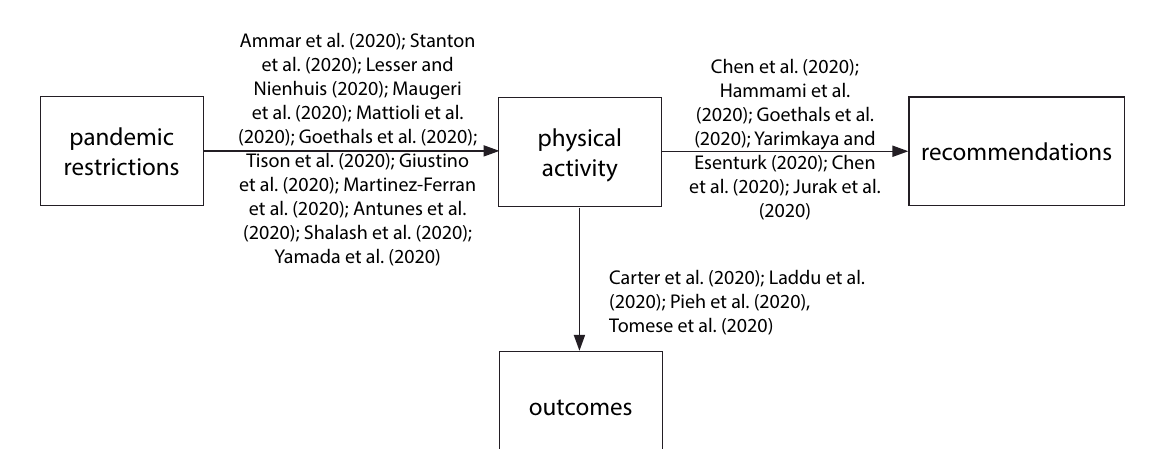
Figure 4. Categorization of the core references in research on physical activity in the COVID-19 context: Source: Own study based on data retrieved from Scopus (15 January